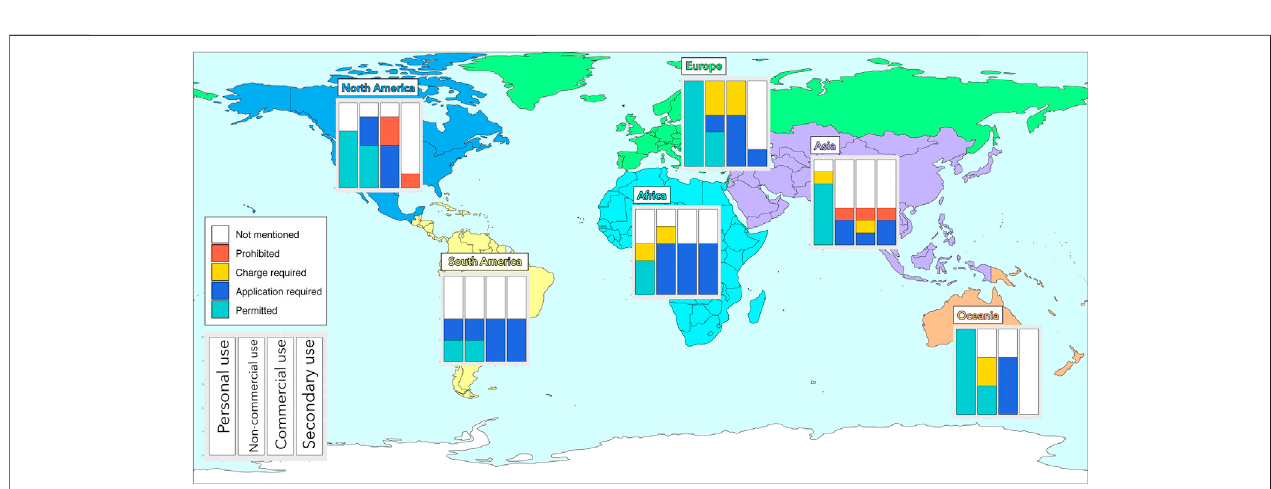
FIGURE6| Stacked barchartsofglobaltrendsofmuseum policies. Thedatawerecollectedfrom Table 1 .Legends areshown ontheleftsideofthe fi gure.These charts were created in R (R Core Team, 2021).